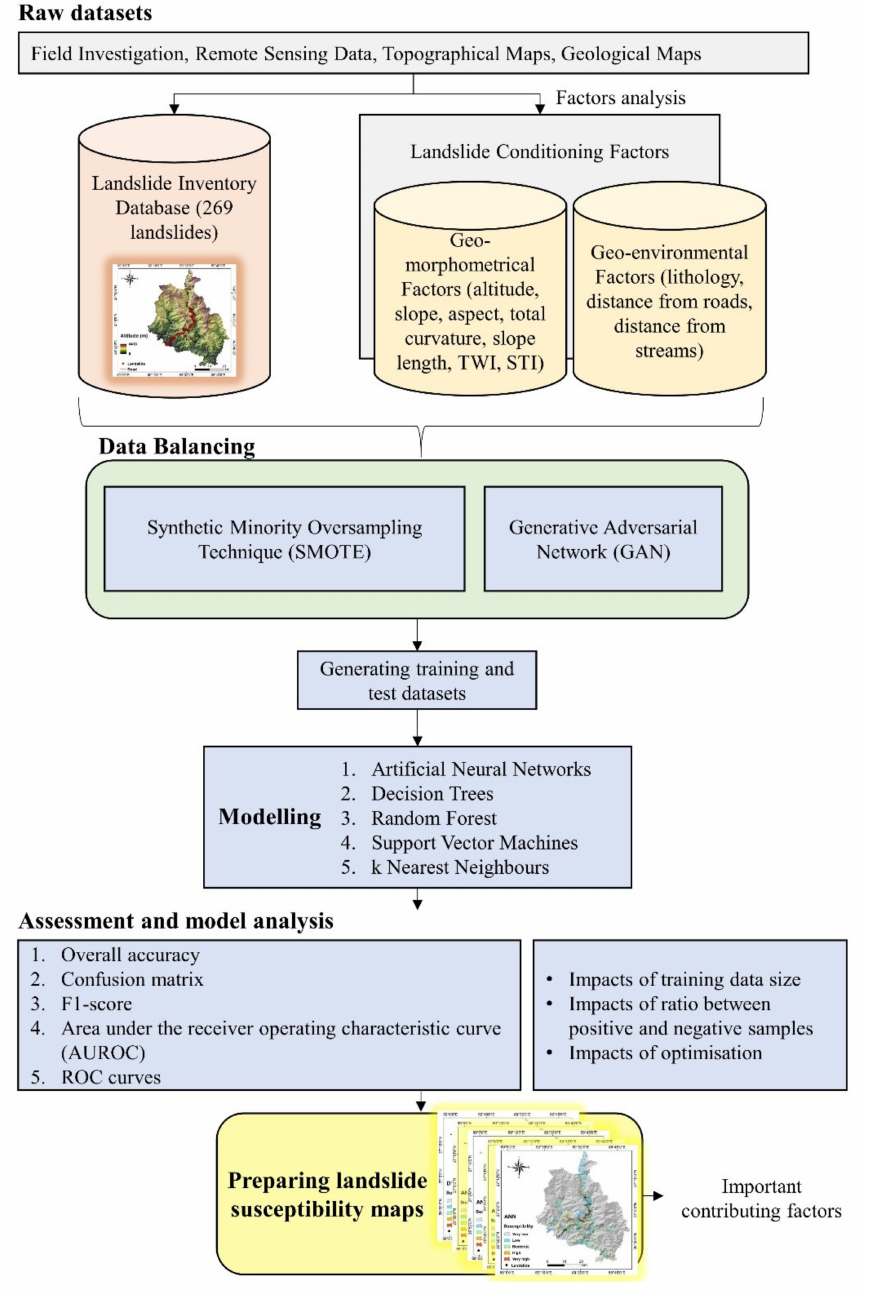
Figure 3. Overview of the proposed methodology for spatial prediction of landslides in